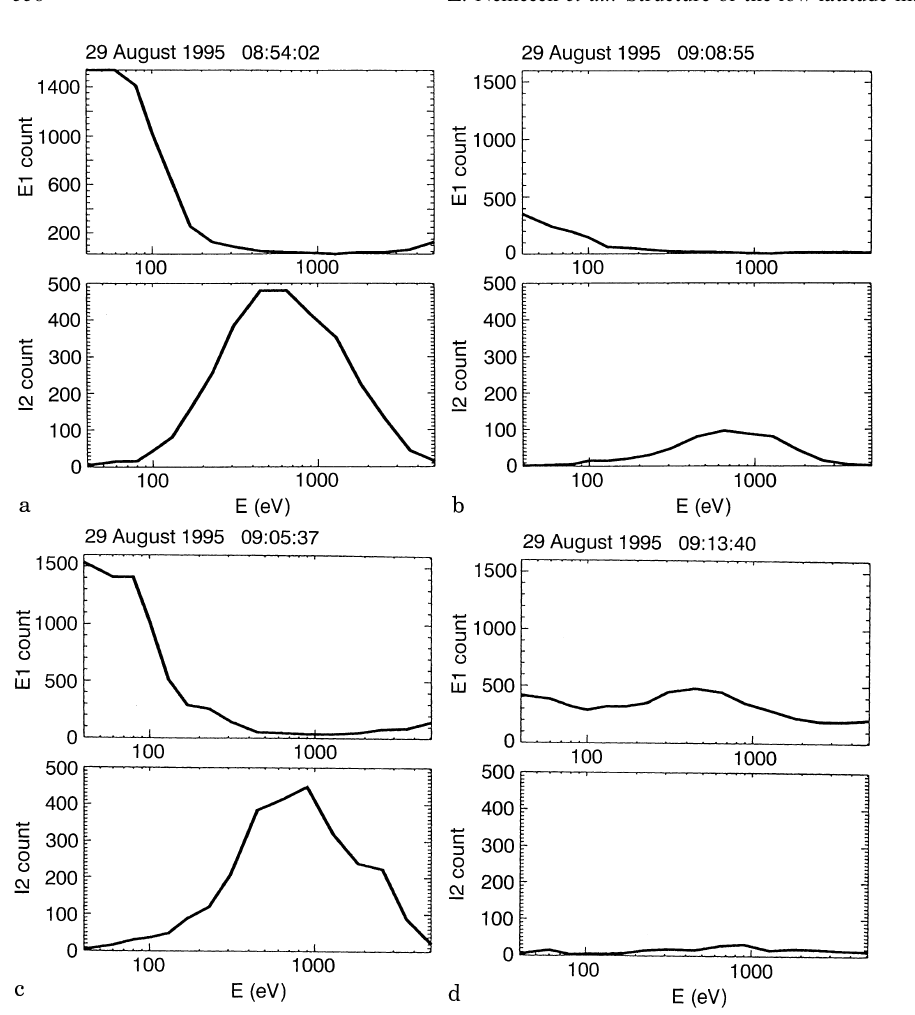
Fig. 7 a-d. Ion-and electron-energy spectra in different plasma regions ( a magnetosheath, b low-density region, c magnetosheath-like region, d LLBL). The corresponding plasma parameters computed from